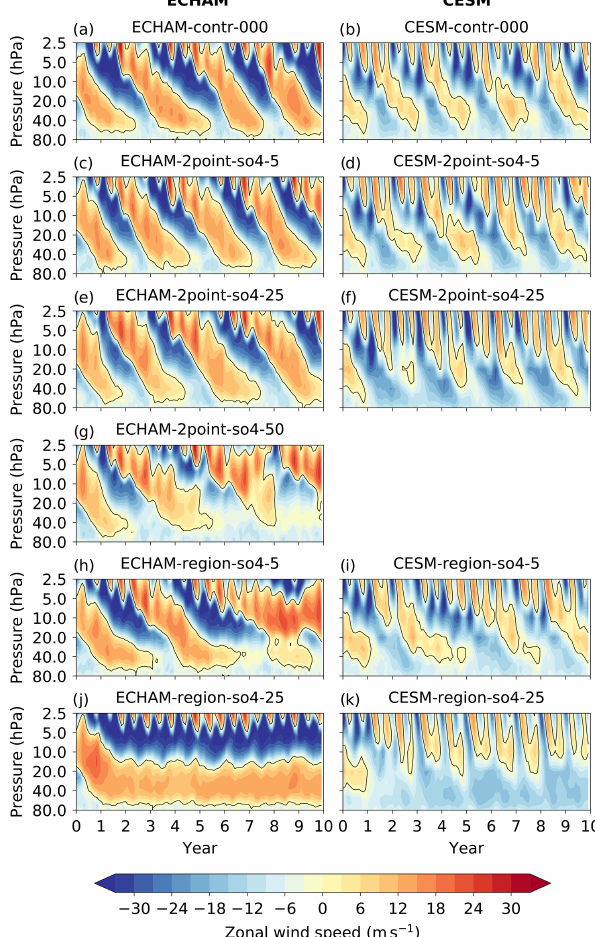
Figure 12. Time–height cross sections of the 5 ◦ N to 5 ◦ S mean zonal wind in the stratosphere over the simulation period of 10 years for the AM − SO 4 injection scenarios in ECHAM (left column) and CESM (right column). The first row shows the control simulation, the second row shows the 2point injections of 5Tg ( S ) yr − 1 , the third row shows the 2point injections of 25Tg ( S ) yr − 1 , the fifth row shows the region injections of 5Tg ( S ) yr − 1 , and the sixth row shows the region injections of 25Tg ( S ) yr − 1 . The 2point injection of 50Tg ( S ) yr − 1 was only performed with ECHAM and is shown in the fourth row. The solid black line marks a tropical mean zonal wind speed of 0ms − 1